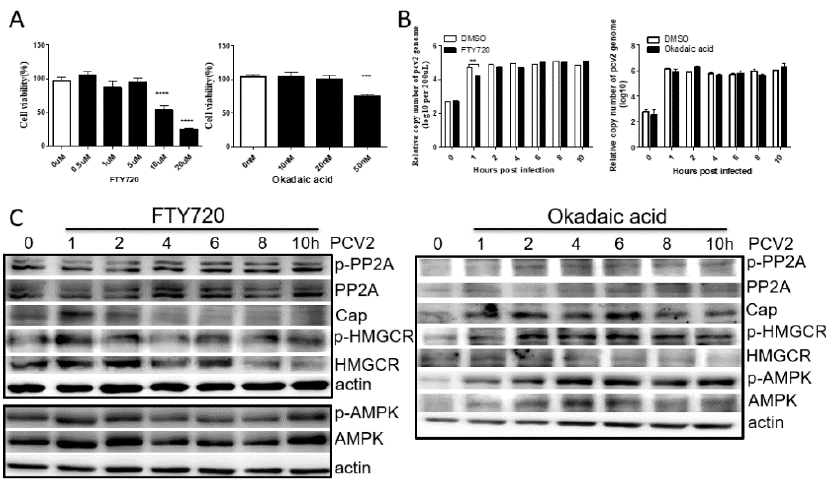
Figure 3. PP2A has little e ff ect on PCV2 infection and HMGCR activity. Cells were treated with FTY720 (PP2A activator) or okadaic acid (PP2A inhibitor) and infected with PCV2, and analyzed by western blot and real-time PCR at the indicated time points. The results are expressed as the mean ± SD of three independent experiments. The experiments were repeated at least three times. **, p < 0.01, ***, p < 0.001, and ****, p < 0.0001. ( A ) Cytopathic e ff ects of drugs. ( B ) Real-time PCR. ( C ) Western blot.